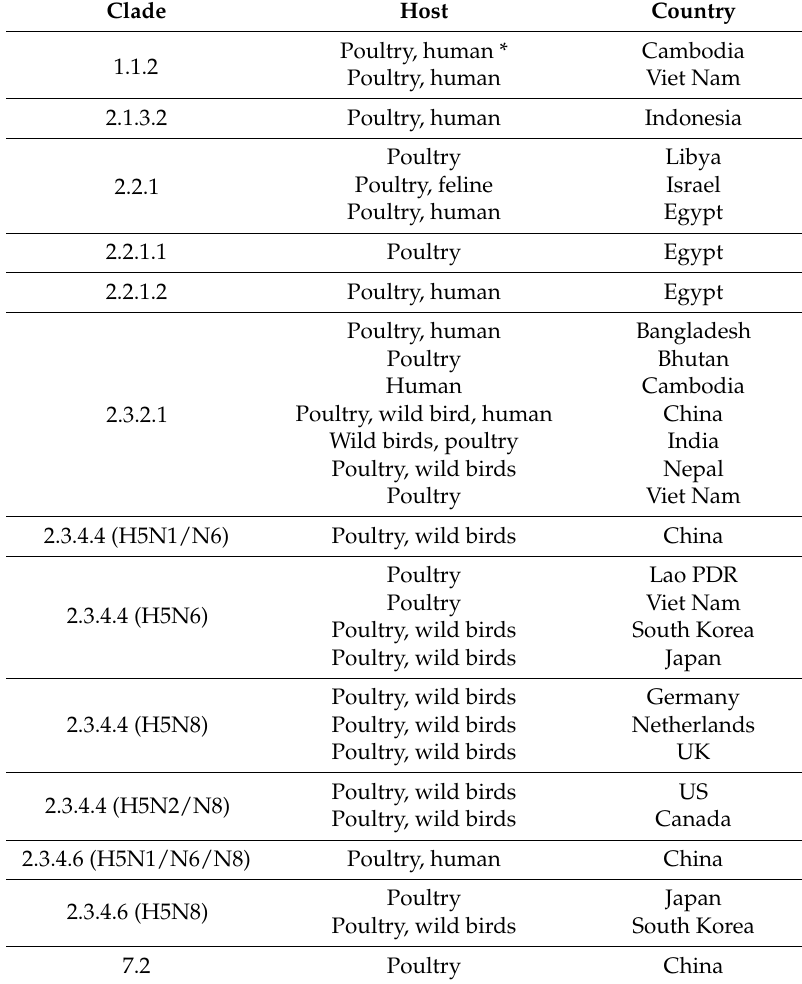
Table 1. Evolution of the Gs/GD lineage of the highly pathogenic avian influenza (HPAI) H5 subtype.